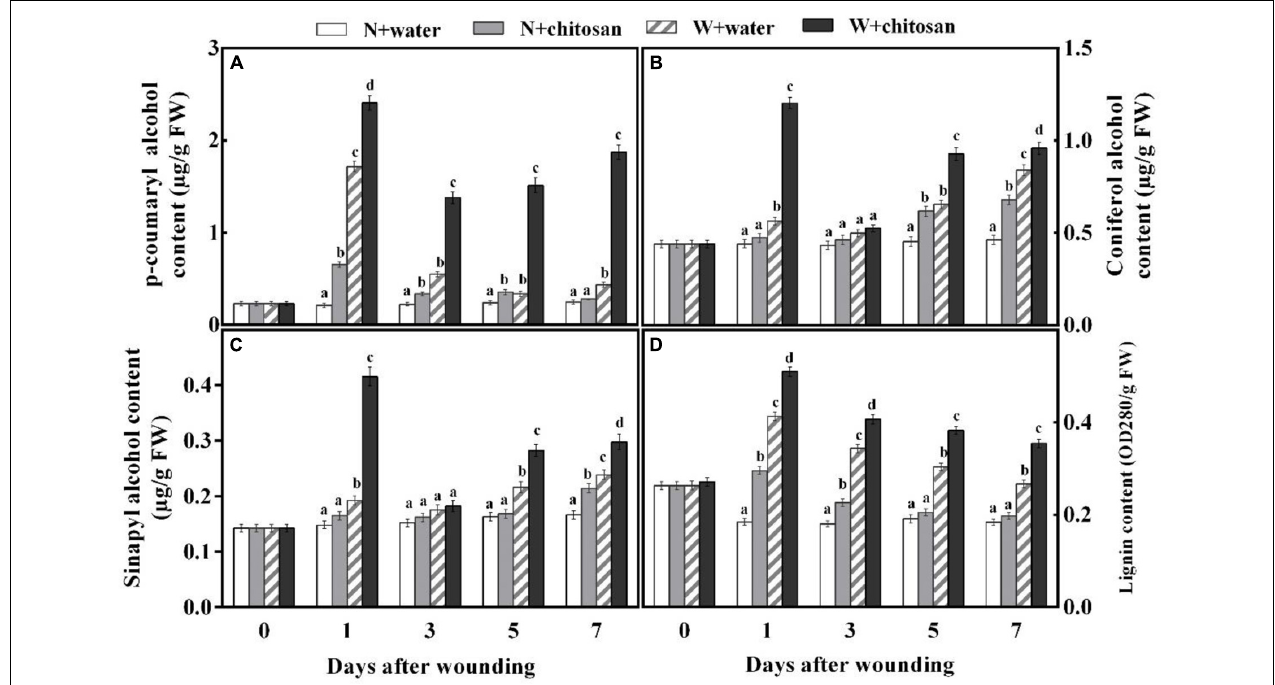
FIGURE 5 | Effect of chitosan treatment on contents of p -coumaryl alcohol (A) , coniferyl alcohol (B) , sinapyl alcohol (C) , and lignin (D) . Non-wounded and treated with sterile water (N + water), non-wounded and treated with chitosan (N + chitosan), wounded and treated with sterile water (W + water), and wounded and treated with chitosan (W + chitosan). Vertical bars indicate standard error of means. Alphabets indicate significant differences ( p <